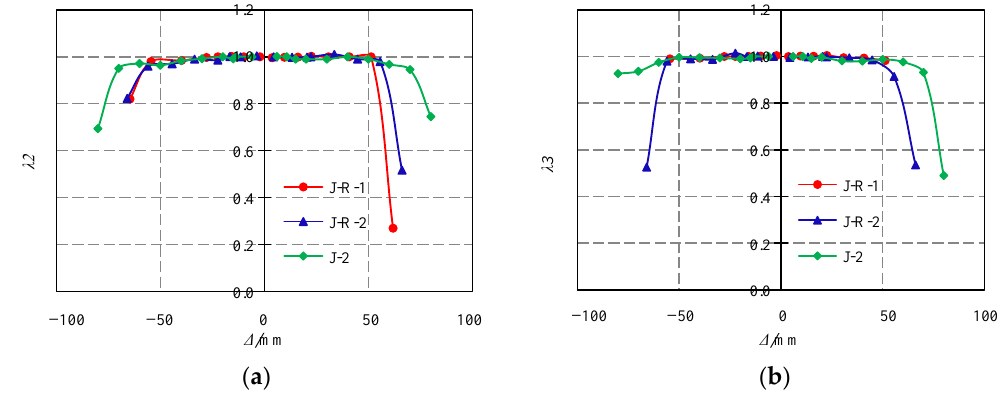
Figure 13. ( a ) Strength reduction curve of λ 2 ; ( b ) strength reduction curve of λ 3 .